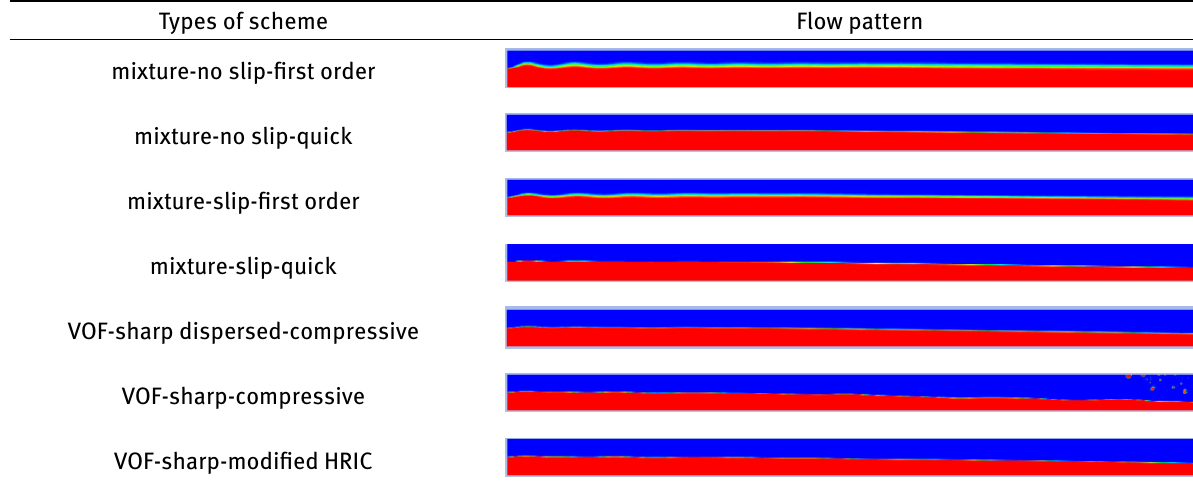
Table 9: Inlet the kerosene above the water for two-phase flow patterns, (L = 2 m, H = 10 cm), mesh (720,000) Types of scheme